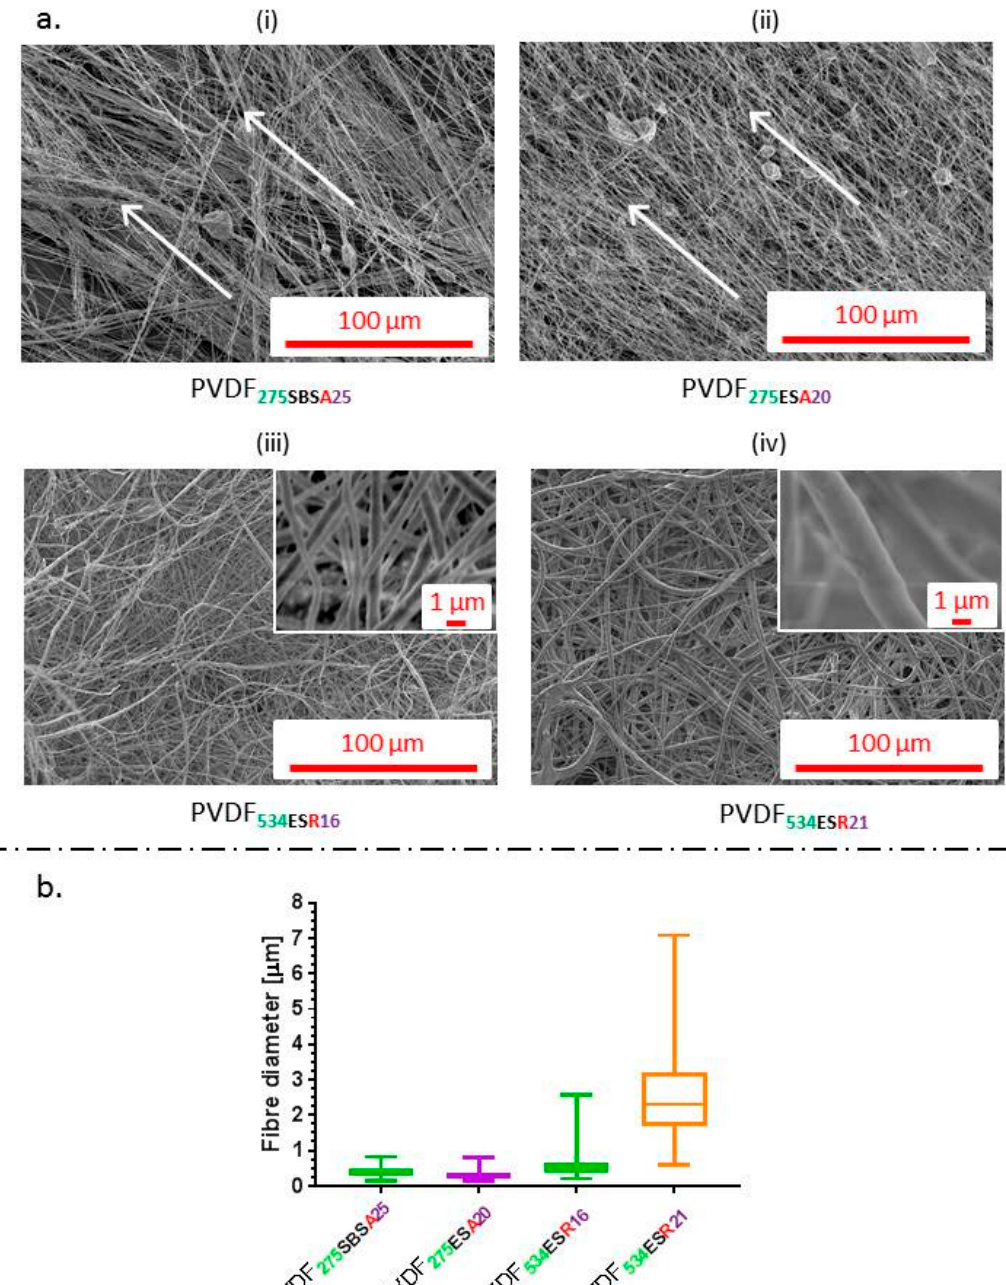
Figure 1. ( a ) Scanning electron microscopy (SEM) images of aligned and random fibres obtained using SBS and ES. White arrows represent the direction of alignment. ( b ) Fibre diameter distribution of the di ff erent fibrous membranes fabricated using SBS and